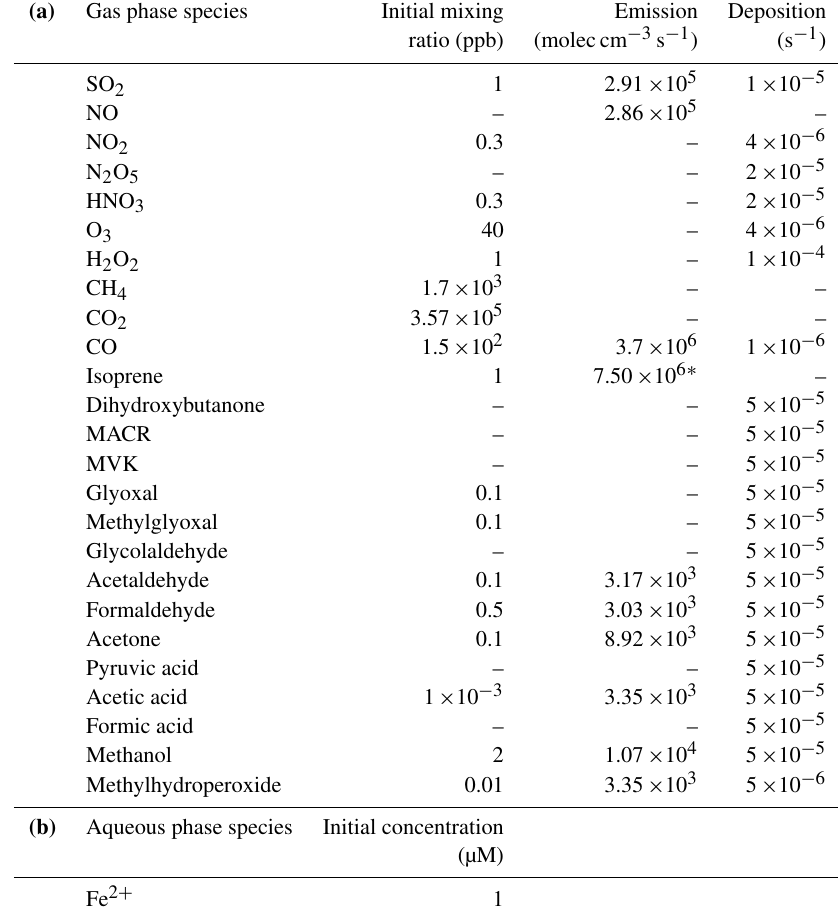
Table 4. (a) Chemical scenario used for the gas phase simulation of 31 days. (b) Aqueous phase initial